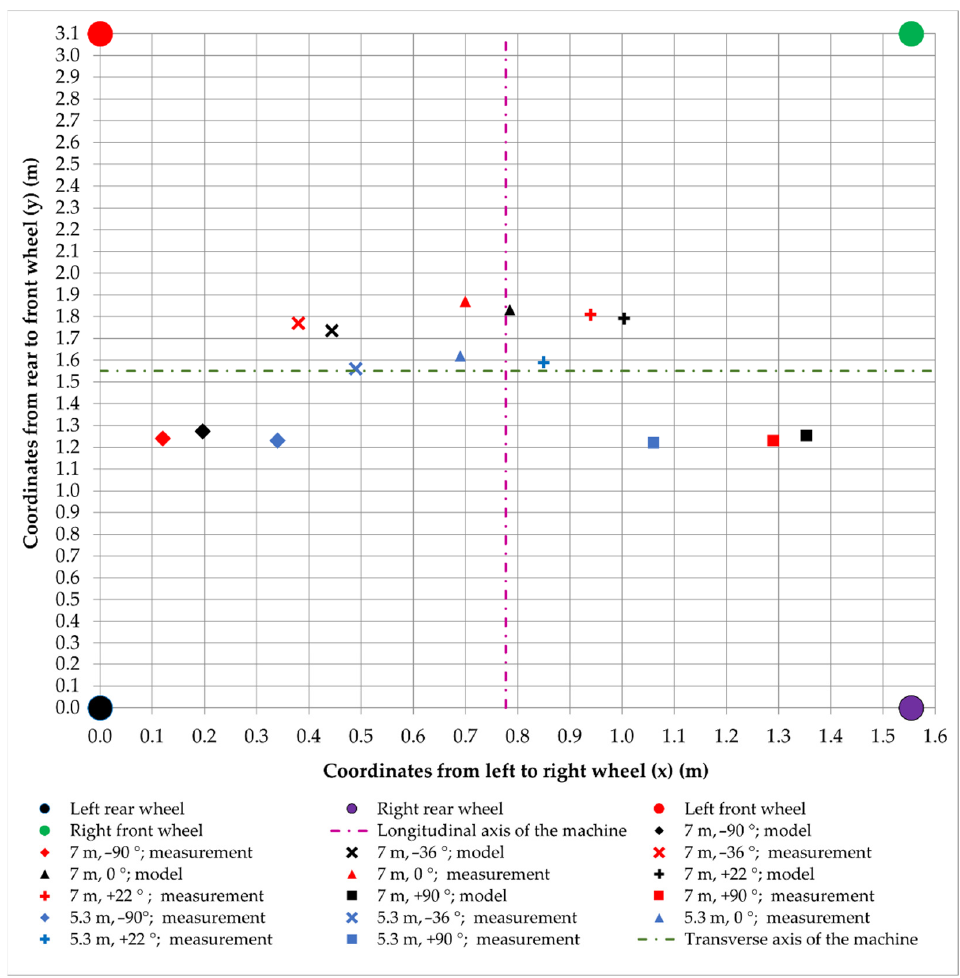
Figure 5. Center of gravity—Position 1. At a full boom reach (7 m) on the axis − 36 ◦ (left from the longitudinal axis), differences recorded between the model and practical measurements in the x and y coordinates were ∆ x = 0.064 m and ∆ y = − 0.035 m, respectively. This means that y verified in practice was higher than its model value (Figure 5). During this comparison, the deviation in the determination of coordinates for the model was 14.41% for x and 2.02% for y. Unlike in the previous position, the extreme load reduction on the front right wheel did not occur, however, the most loaded wheel was the left front wheel, the load of which was 3360 kg, i.e., 43.41% of total machine weight (7740 kg). In the boom reach of 5.3 m on this axis, the wheel load was reduced to 2670